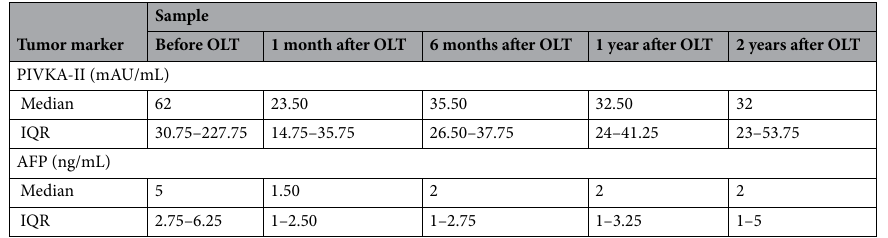
Table 3. Median levels of PIVKA-II and AFP in serum of HCC patients before and after transplantation. OLT orthotopic liver transplant, IQR interquartile range.